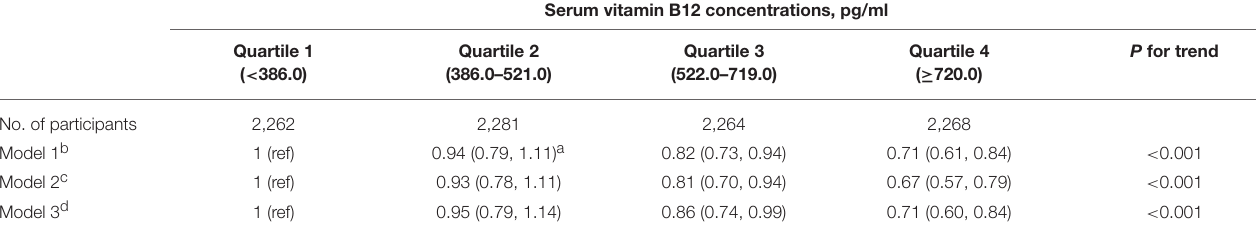
Serum vitamin B12 concentrations, pg/ml